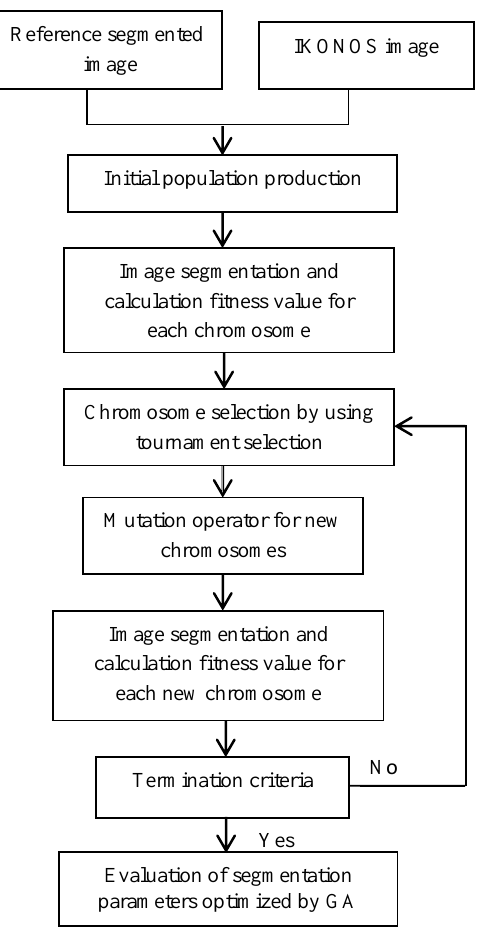
Figure 1. Flowchart of the proposed algorithm for optimizing parameters of multi resolution segmentation